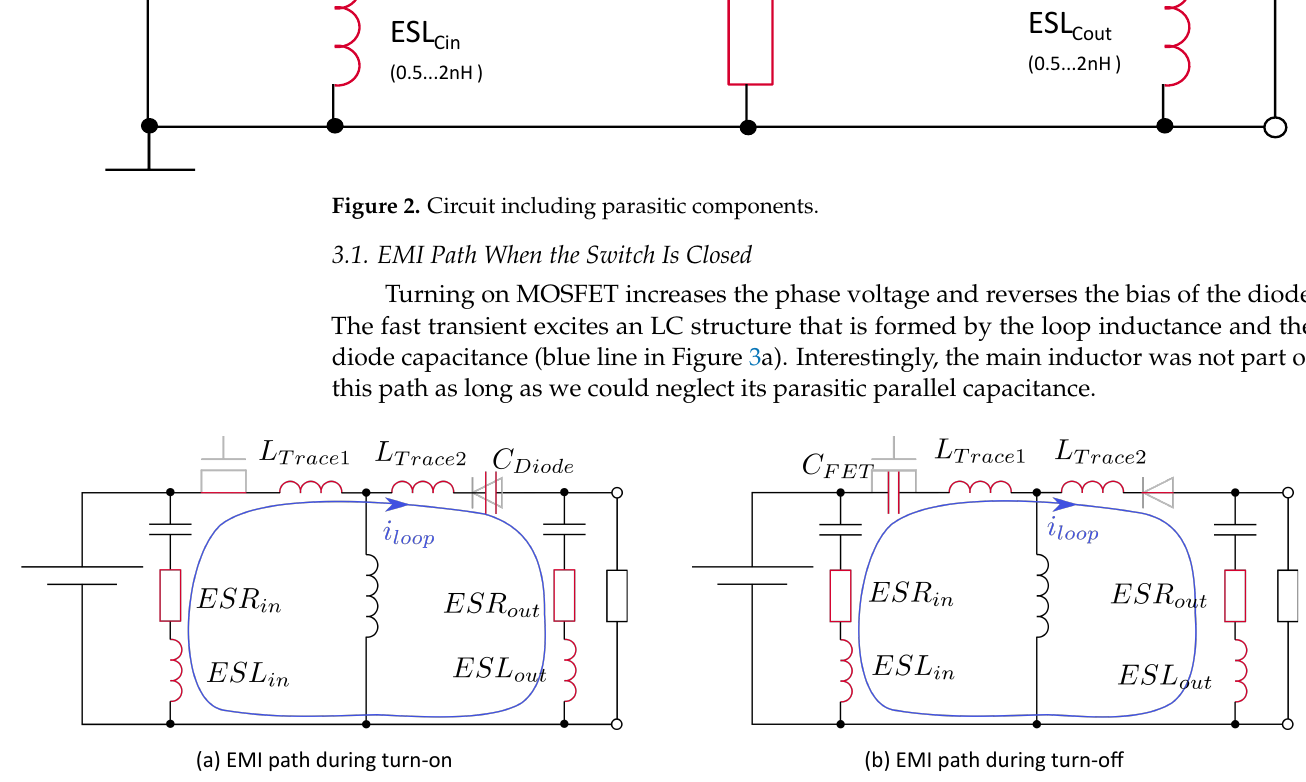
Figure 3. EMI path during turn-on and